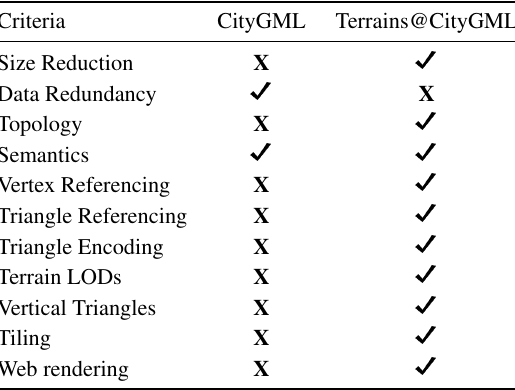
Table 2: CityGML vs